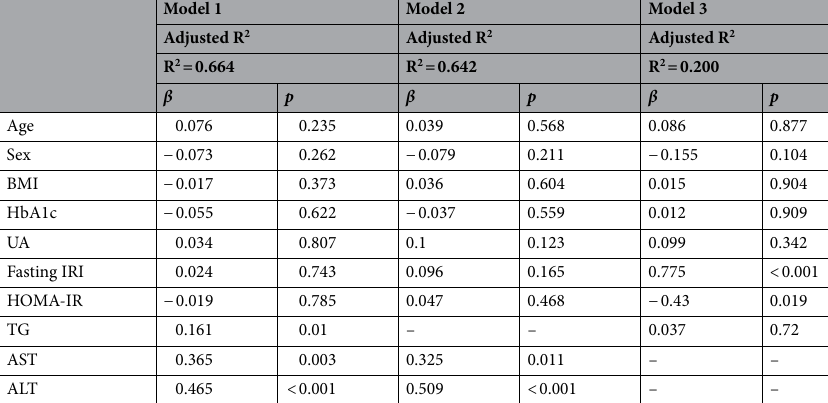
Model 1 Model 2 Model